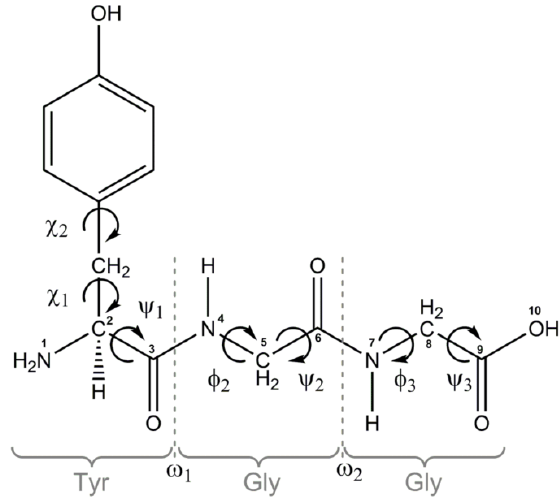
Figure 1. Numbering system employed for YGG with definition of backbone and side-chain dihedral